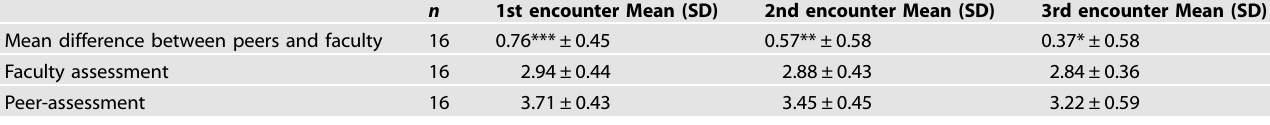
Table 1. The mean difference between faculty and peer-assessment in each of the 3 encounters along with peer-assessment and faculty assessment.